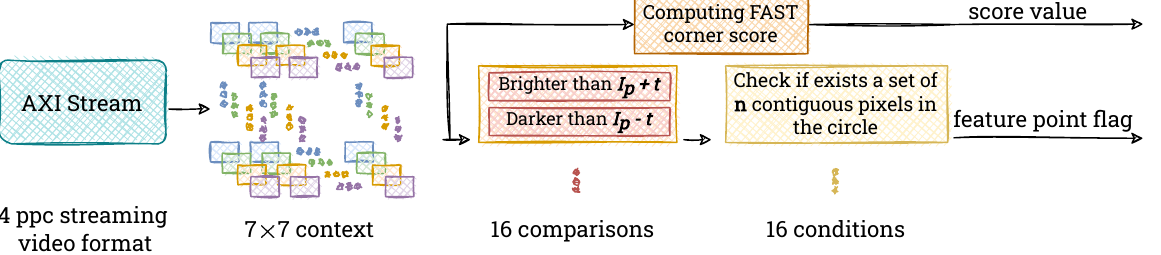
Figure 4. Scheme of our hardware implementation of the FAST detector. First, we generate 7 × 7 pixel contexts (4 due to the 4 ppc format). Then, for each of them, we test whether its centre is a feature point (feature point flag) and determine its stability (score value). The feature point flag is a signal which indicates that a feature point has been found. It is worth noting the high degree of parallelisation of calculations (e.g., 16 comparisons between centre and circle’s points and score value computed simultaneously with the feature point flag), which in addition are performed simultaneously for all generated